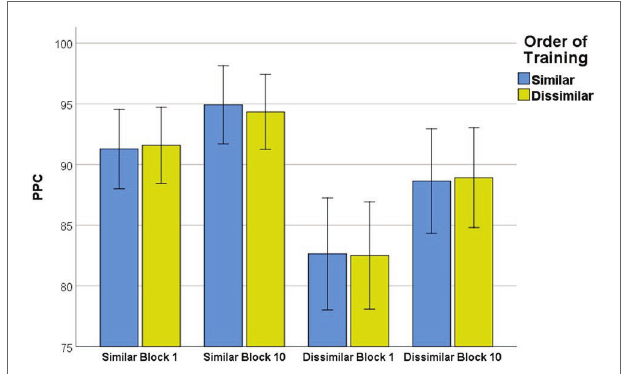
FIGURE 2 | Mean phoneme accuracy for similar and dissimilar nonwords during training (blocks 1 and 10). Error bars - 95%